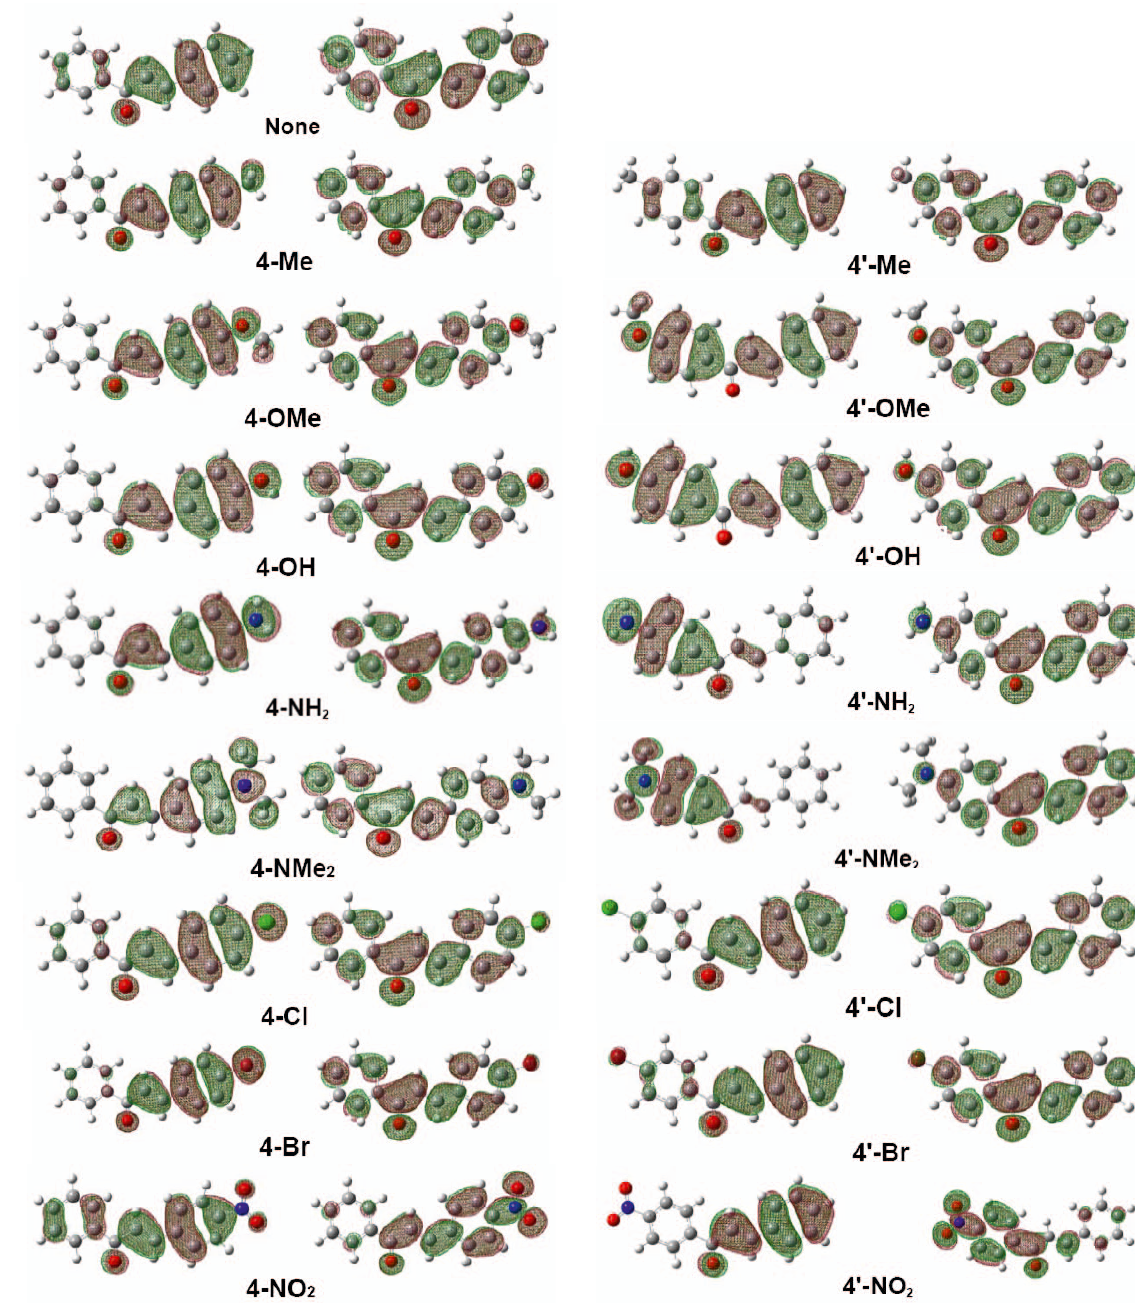
Figure 4. The electron density plots of the HOMO(from left to right,the first and third column of panels) and LUMO(from left to right,the second and fourth column of panels) of para-monosubstituted